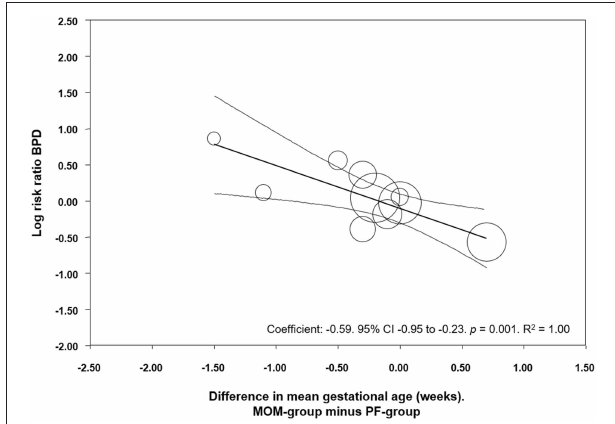
FIGURE 5 | Meta-regression of MD in GA between the MOM and PF group, and risk of BPD. CI, confidence interval; BPD, bronchopulmonary